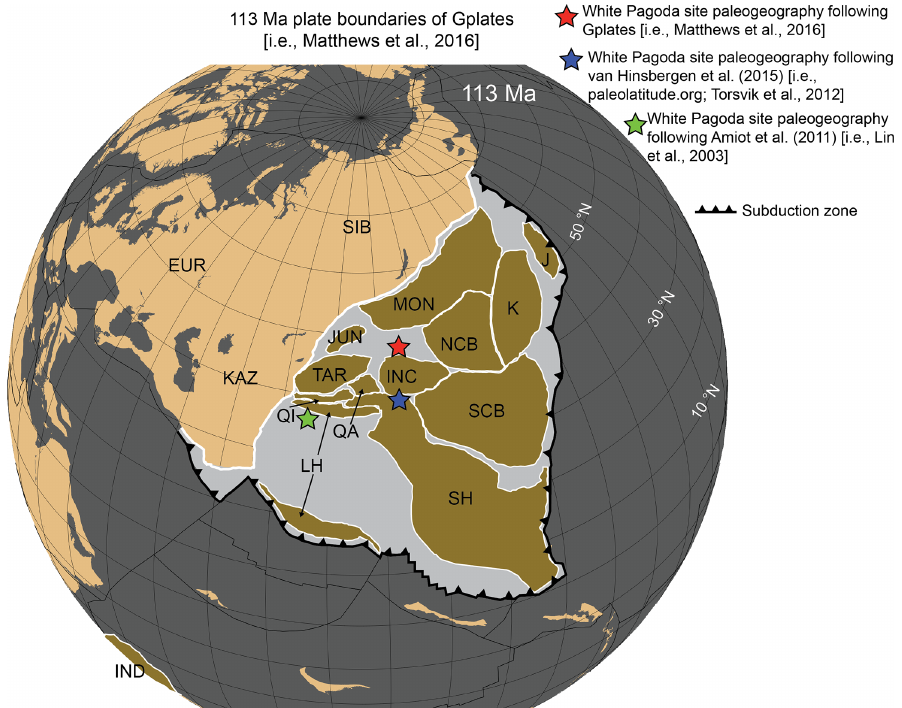
Figure 6. Paleogeographic reconstruction of plate boundaries at ca. 113Ma (Matthews et al., 2016) using the Gplates software. Approximate location of the White Pagoda site following Matthews et al. (2016) is plotted in red. Additional paleogeographic reconstructions are also plot- ted for comparison (Lin et al., 2003; Torsvik et al., 2012), although these paleolocations are inconsistent with plate boundary reconstructions shown here (i.e., do not follow Matthews et al., 2016). The Aptian–Albian paleolatitude using the Gplates software is more consistent with the cooler temperatures indicated by clumped isotope